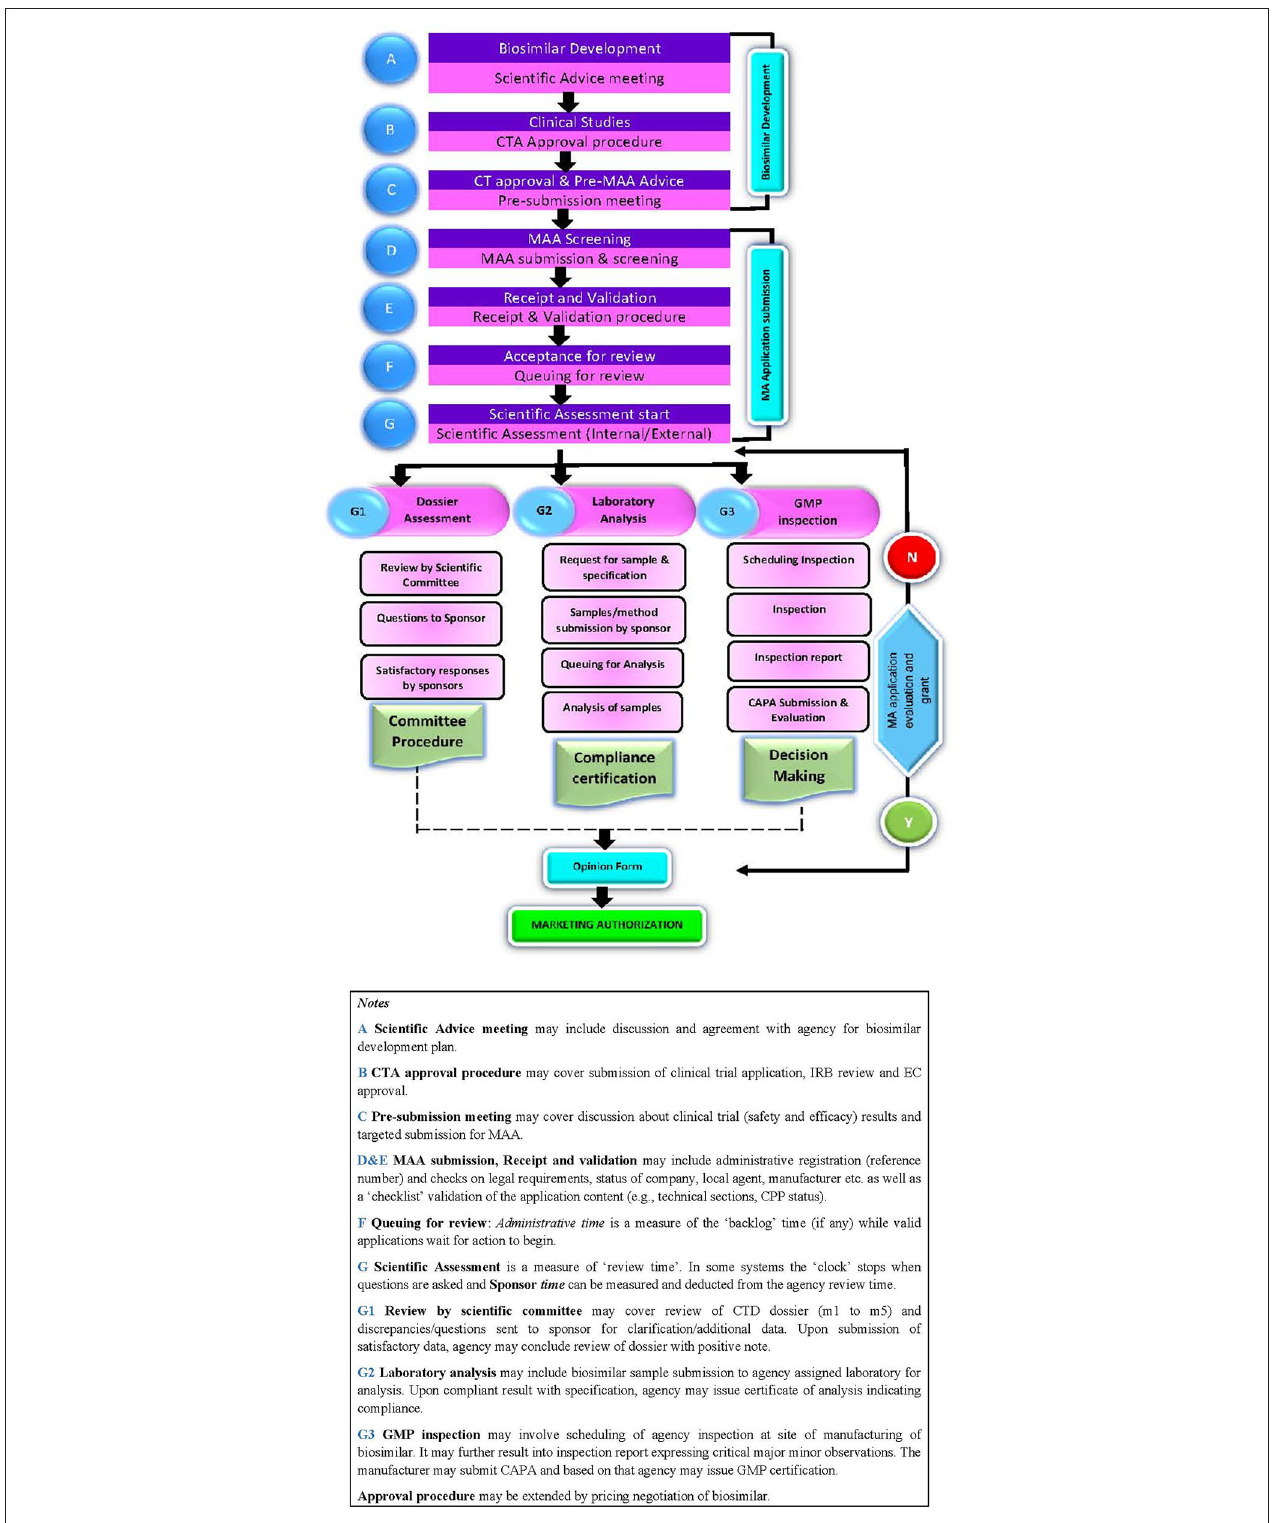
FIGURE 1 | Marketing authorisation approval milestones.